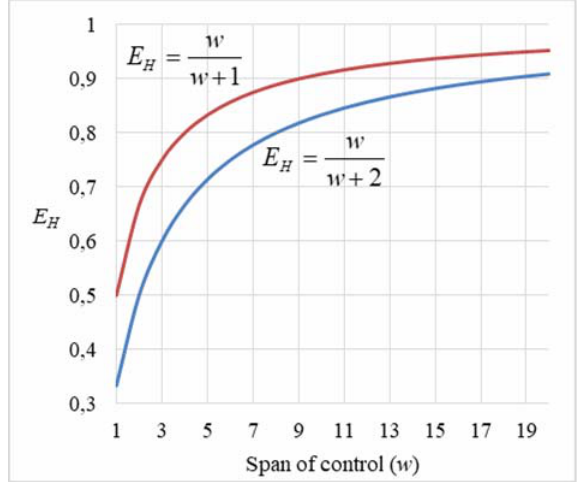
Figure 6: The dependence of the hierarchy efficiency on the span of control. Obtained by the interval of (8). From (8), we can compute